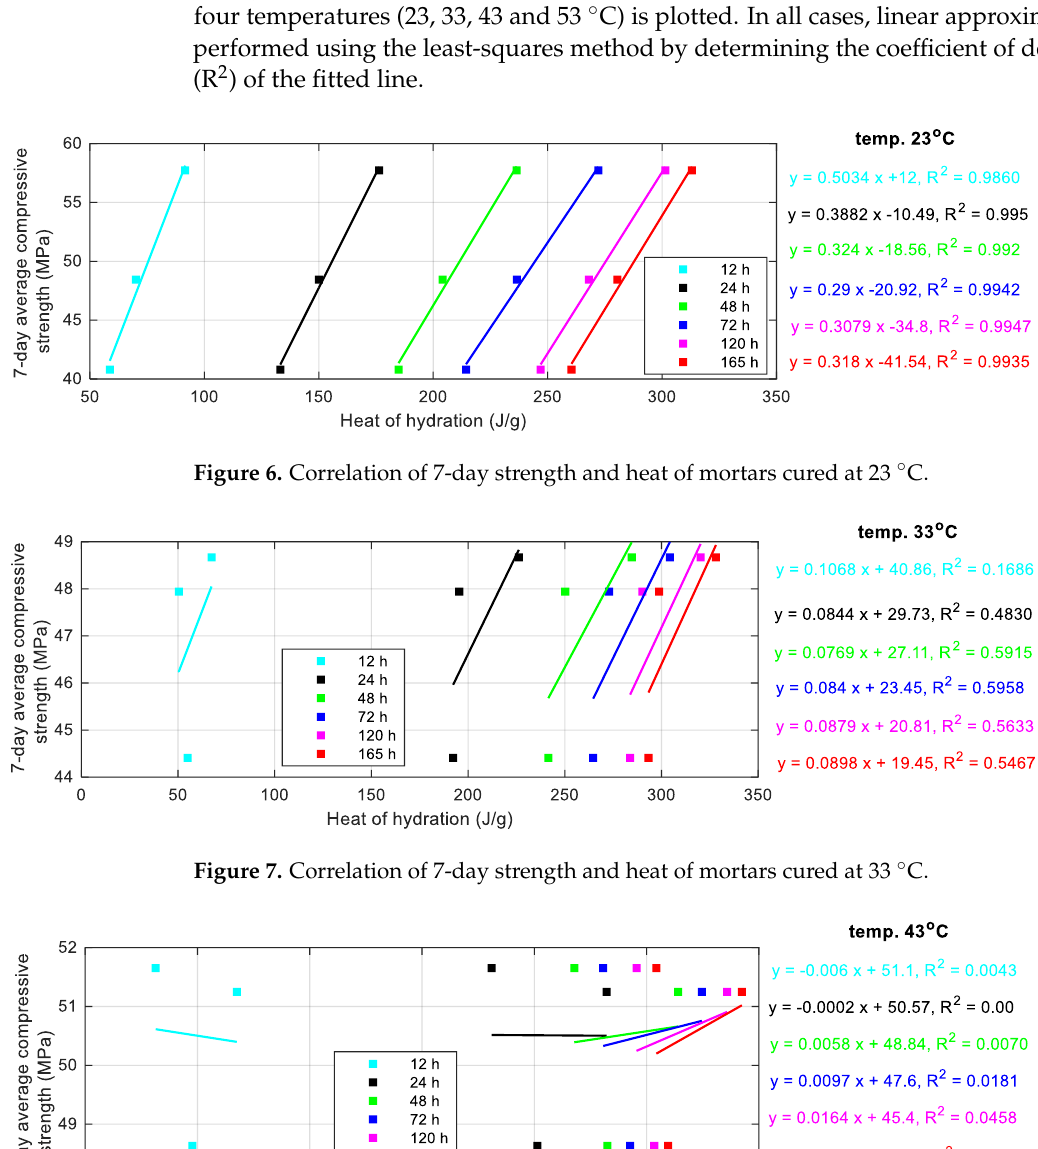
Figure 8. Correlation of 7-day strength and heat of mortars cured at 43 °C.